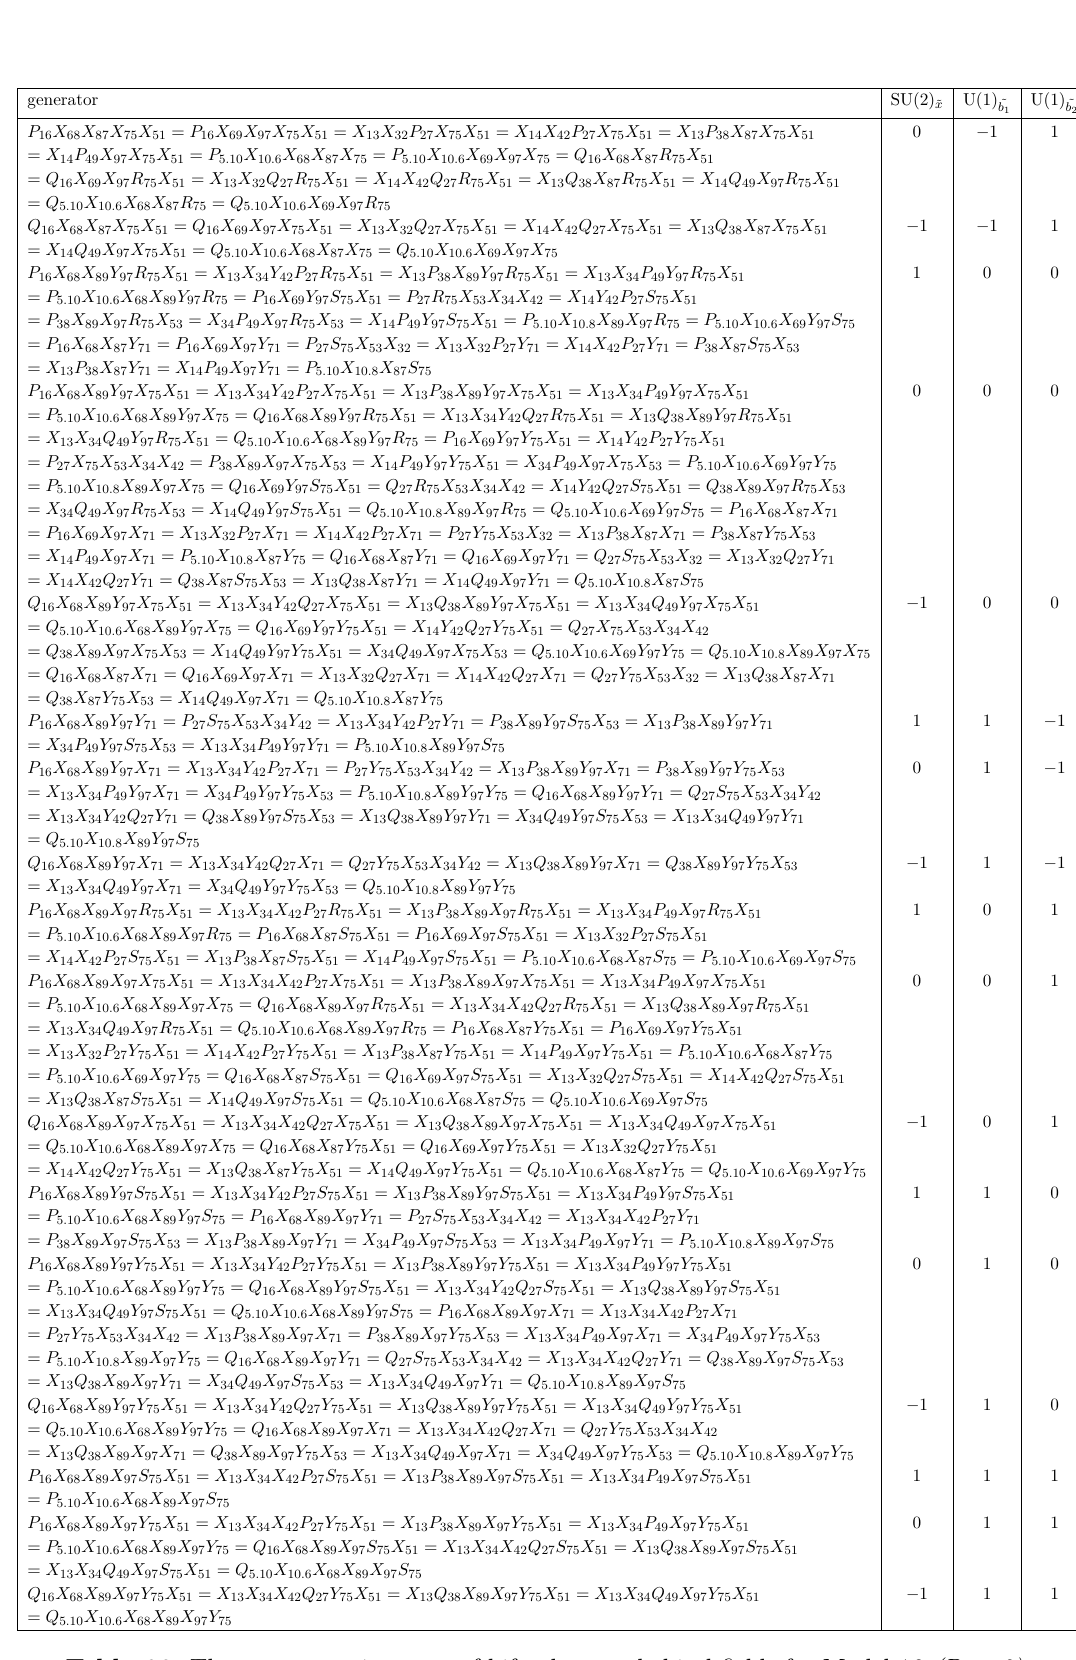
Table 66 . The generators in terms of bifundamental chiral fields for Model 16 (Part 2)